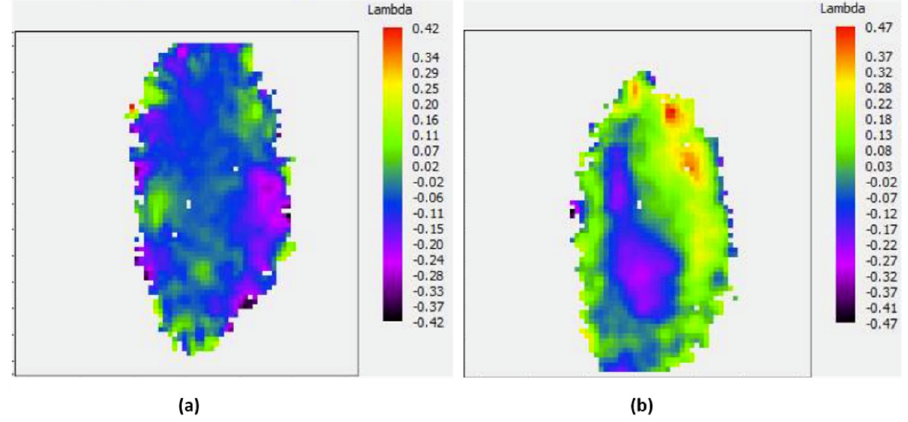
Figure 13. False color map of the 25th harmonic wavefront after passing through the 300 nm aluminum foil ( a ) before and ( b ) after the irradiation by the 3 keV FEL.